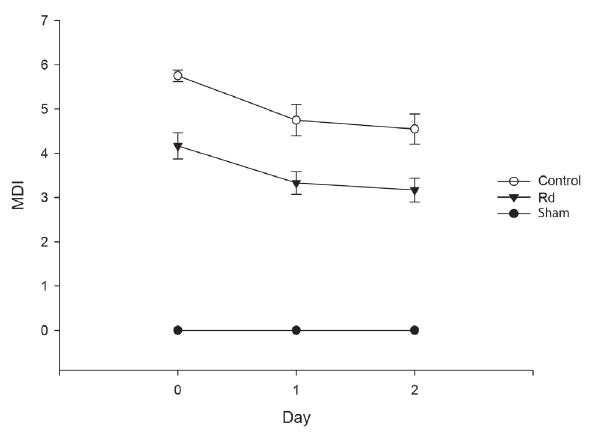
Fig. 1 - Motor deficit index (MDI) evaluated at days 0, 1, and 2 after induction of spinal cord ischemia-reperfusion injury. Each symbol represents the MDI score of each group. Rats in the sham group demonstrated normal motor function as represented by an MDI score of 0. MDI scores were significantly lower in the Rd group than in the control group throughout the entire experimental period. All values are presented as mean ± standard error of